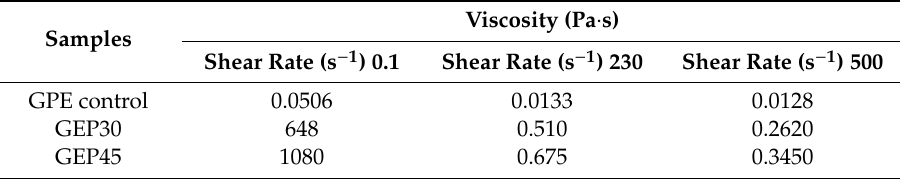
Table 3. The viscosities of GEP 30, GEP 45 and GPE control precursor at di ff erent shear